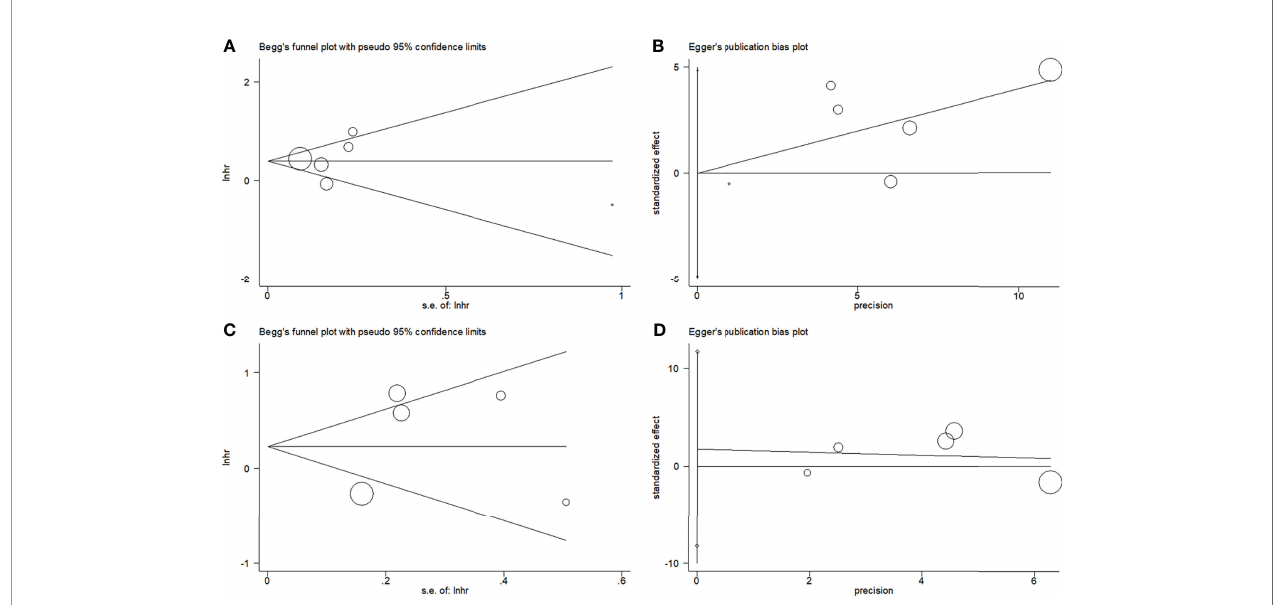
FIGURE 5 | Plots for publication bias test. (A) Begg ’ s funnel plot for OS, p=0.851; (B) Egger ’ s publication bias plot for OS, p=0.223; (C) Begg ’ s funnel plot for PFS, p=0.806; (D) Egger ’ s publication bias plot for PFS,